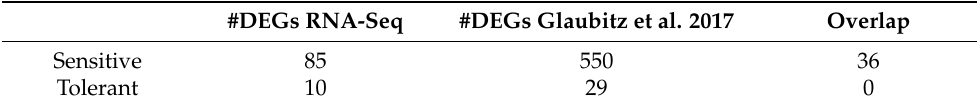
Table 4. Assessment of significant differentially expressed genes (DEGs) from the RNA-Seq analysis of leaf blade segments (base, middle, tip) and a whole leaf microarray analysis [22] for sensitive